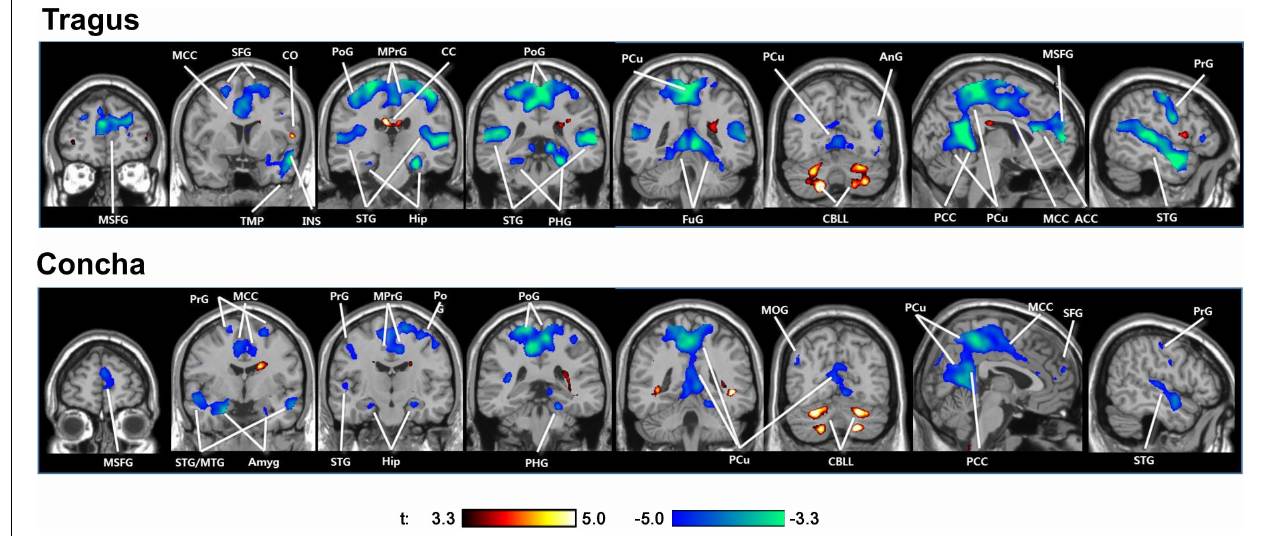
FIGURE 3 | Activations (red) and deactivations (blue) induced by tVNS at the tragus and cymba conchae in tinnitus patients. tVNS resulted in deactivation of the auditory and limbic systems, as well as a number of other cortical areas. ACC/MCC/PCC, anterior/middle/posterior cingulate cortex; Amyg, amygdala; AnG, angular gyrus; CC, corpus callosum; CBLL, cerebellum; FuG, fusiform gyrus; Hip, hippocampus; LiG, lingual gyrus; MOG, middle orbital gyrus; MTG/STG, middle/superior temporal gyrus; PCu, precuneus; PoG/PrG, postcentral/precentral gyrus; SFG, superior frontal gyrus; TMP, temporal